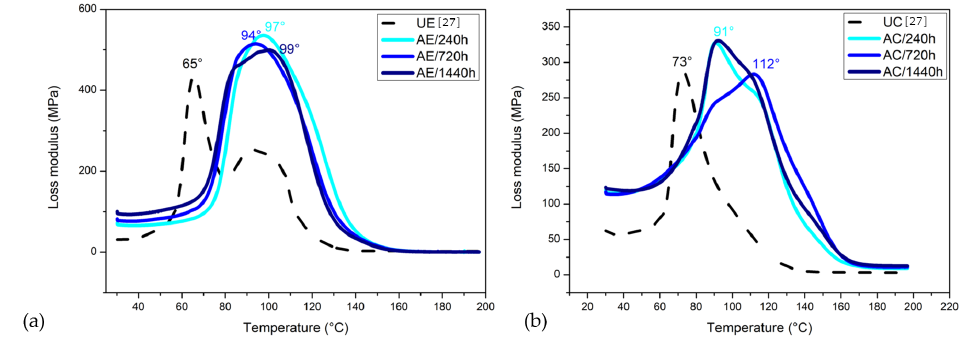
Figure 11. DMA loss modulus (E (cid:48)(cid:48) ) curves for ( a ) epoxy resin and its composite unaged and water- immersion-aged ( b ).